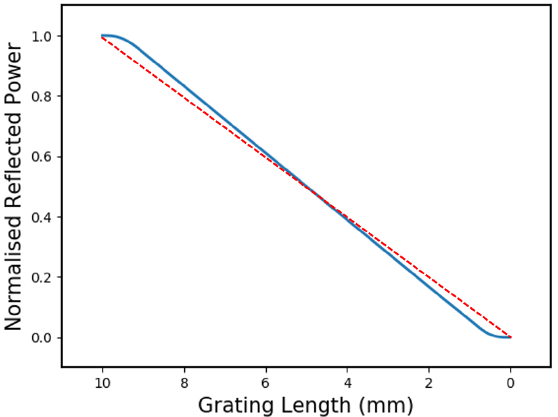
Figure 7. Graph showing how apodisation affects CFBGs in detonation velocity tests. The grating is 10 mm long, 20% reflectivity, with a 10 nm bandwidth and a 10% sine-shaped apodisation at either end. The apodisation can be seen as roll-in/roll-off in power as each end of the grating is destroyed. The dashed red line shows the ideal case, where reflected power is linearly proportional to grating